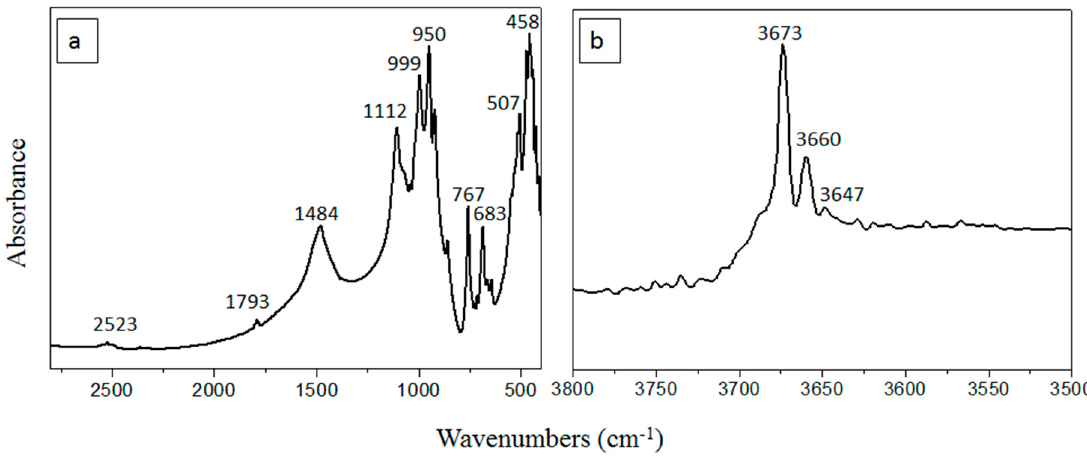
Figure 4. Fourier Transform InfraRed Spectroscopy (FT-IR) spectrum at low ( a ) and at height ( b ) wavenumbers.